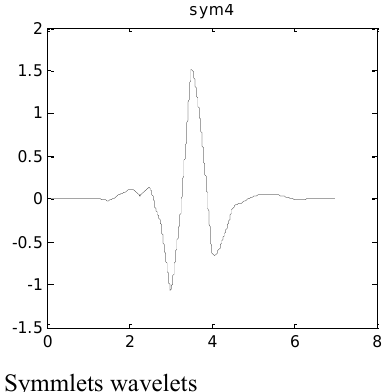
Figure 8: Coiflets scalet ϕ and wavelet ψ(L =